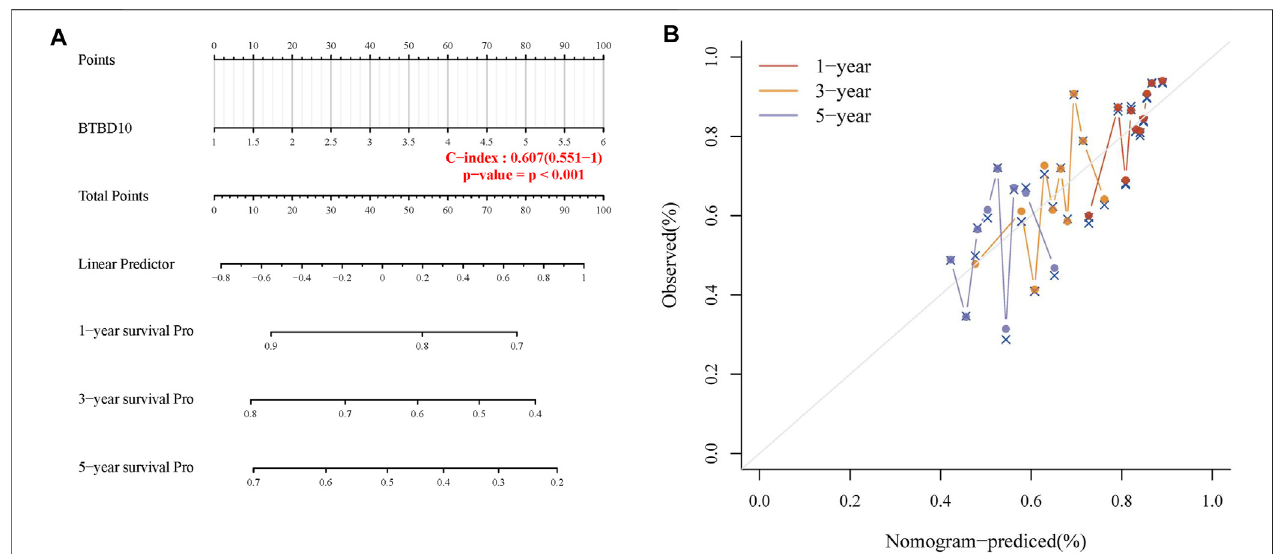
FIGURE4|(A) Nomogramtopredictthe1-year,3-yearsand5-yearsprogression-freesurvival(PFS)ofHCCpatients; (B) CalibrationcurveforthePFSnomogram model with dashed diagonal line represents the ideal nomogram.